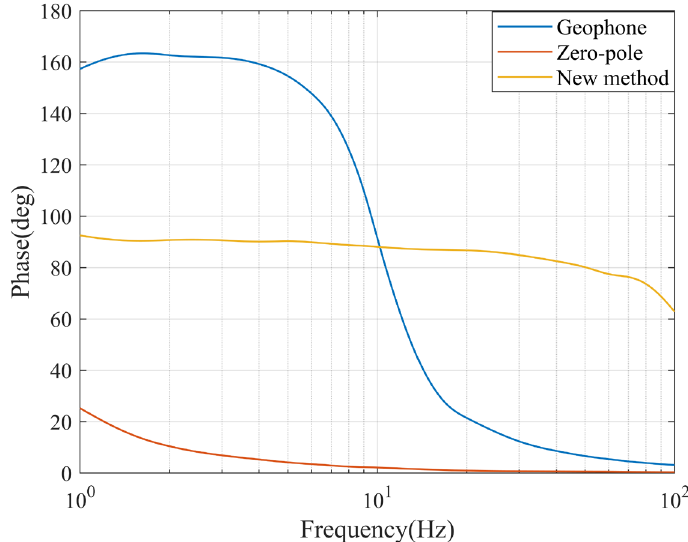
Figure 9. Phase difference to the reference sensor.